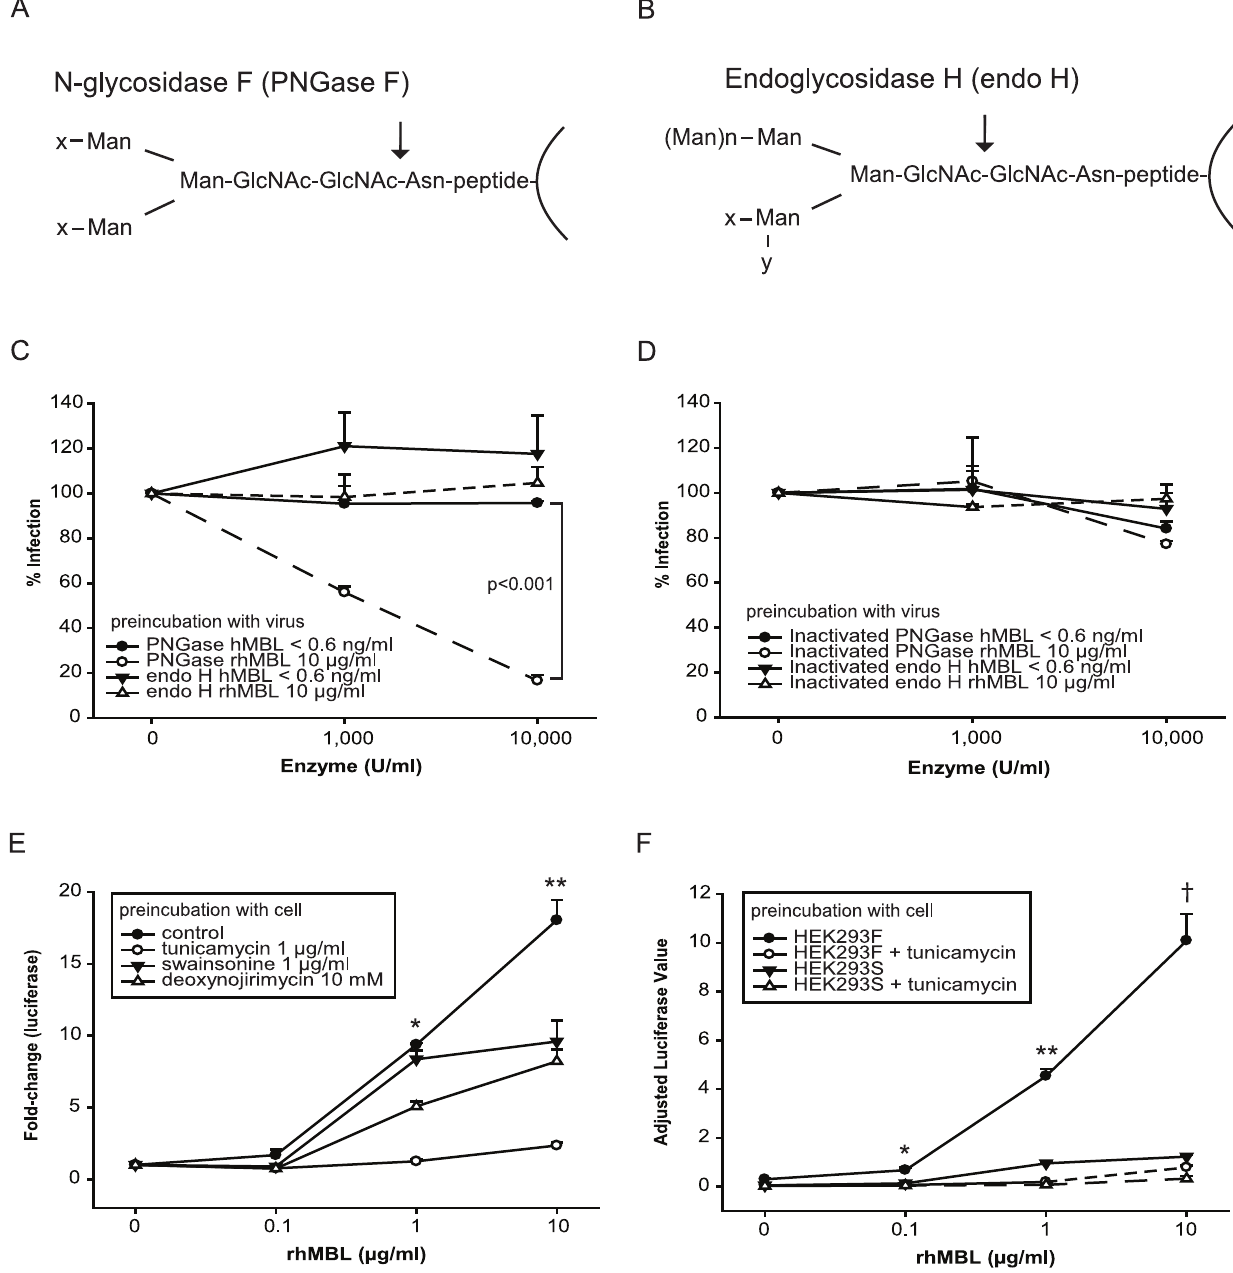
Figure 3. MBL targets N -linked glycans on viral and cellular surfaces. The cleavage sites of two endoglycosidases are shown (A,B). N- glycosidase F (PNGase F) is an amidase that cleaves the linkages between the innermost GlcNAc and asparagine residues within high-mannose, hybrid and complex oligosaccharides of N -linked glycoproteins, thereby producing carbohydrate-free peptides without any potential ligands for MBL. Endoglycosidase H (endo H) cleaves linkages within the diacetylchitobiose stem of high-mannose of N -linked glycoproteins, thereby generating a truncated sugar molecule with one N -acetylglucosamine residue (a potential target for MBL) remaining on the asparagine. Man, mannose; GlcNAc, N - acetylglucosamine; asn, asparagine; 6 and y, various oligosaccharides; n=2–150 residues. We preincubated HIV-EBOV-GP virion-like particles (1200 pg p24/100 m l) at 37 u C for 1 hour with (C) PNGase F or endo H (0–10,000 U/ml), or (D) the same concentrations of heat inactivated enzymes. Then we incubated the viruses with 5% MBL-deficient serum in the presence or absence of rhMBL at 37 u C for 1 hour before infecting HEK293F cells. Significant differences are shown. (E) We preincubated HEK293F cells at 37 u C for 1 hour with chemicals (tunicamycin, swainsonine or deoxynojirimycin) that inhibit various stages of N -linked glycosylation. Then we infected cells with HIV-EBOV-GP virion-like particles (1200 pg p24/ 100 m l) that had been preincubated with 5% MBL-deficient serum and supplemented with various concentrations of rhMBL. Significant differences are shown. * and **, p , 0.001 (all pairwise comparisons at 1 and 10 m g/ml rhMBL, respectively). (F) We cultivated HEK293F and HEK293S (deficient in N -acetylglucosaminyltransferase I) cells in 5% MBL-deficient serum which was supplemented with various concentrations of rhMBL. We infected cells with HIV-EBOV-GP virion-like particles (1200 pg p24/100 m l) in the absence or presence of 1 m g/ml tunicamycin. Statistical differences among inhibitors at various rhMBL concentrations are shown. *, ** and { , p , 0.005 (all pairwise comparisons at 0.1, 1 and 10 m g/ml rhMBL, respectively). Luciferase values were adjusted for cell viability using alamarBlue (resazurin reduction assay). All experiments were performed twice in quadruplicate. doi:10.1371/journal.pone.0060838.g003 PLOS ONE |